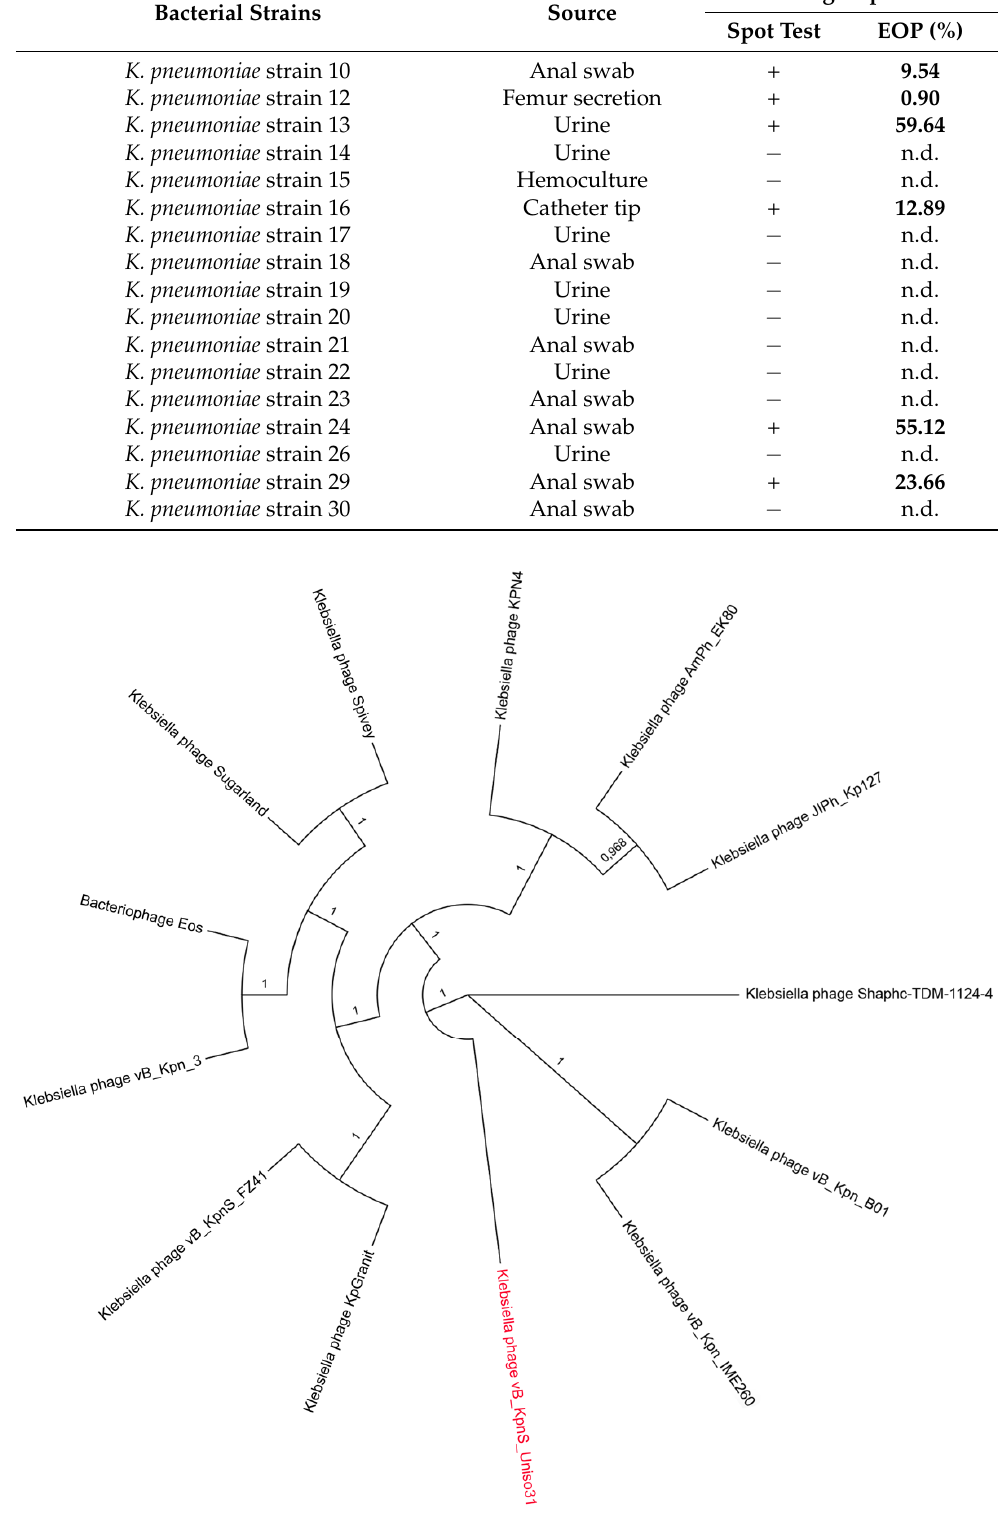
Figure 5. Phylogenetic tree calculated using the core protein clusters from 12 phages connected with phage vB_KpnS_Uniso31 (highlighted in red). Sequences of protein clusters were used for a maximum likelihood (ML) phylogenetic reconstruction using 1000 bootstrap replicates.